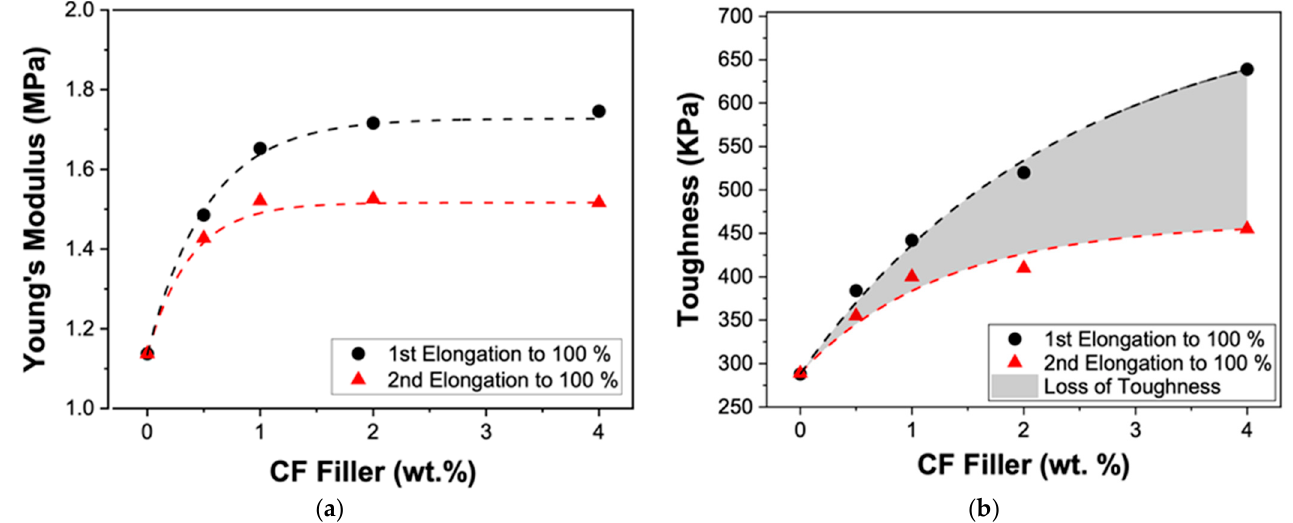
Figure 5. ( a ) Young’s Modulus and ( b ) toughness change as a function of the amount of CF filler. Young’s Modulus and toughness values are from the stress-strain curves of samples for the 1st trials (black circles; 1st elongation to 100%) and the 2nd trials (red triangle; 2nd elongation to 100%). The gray area is the loss of toughness.